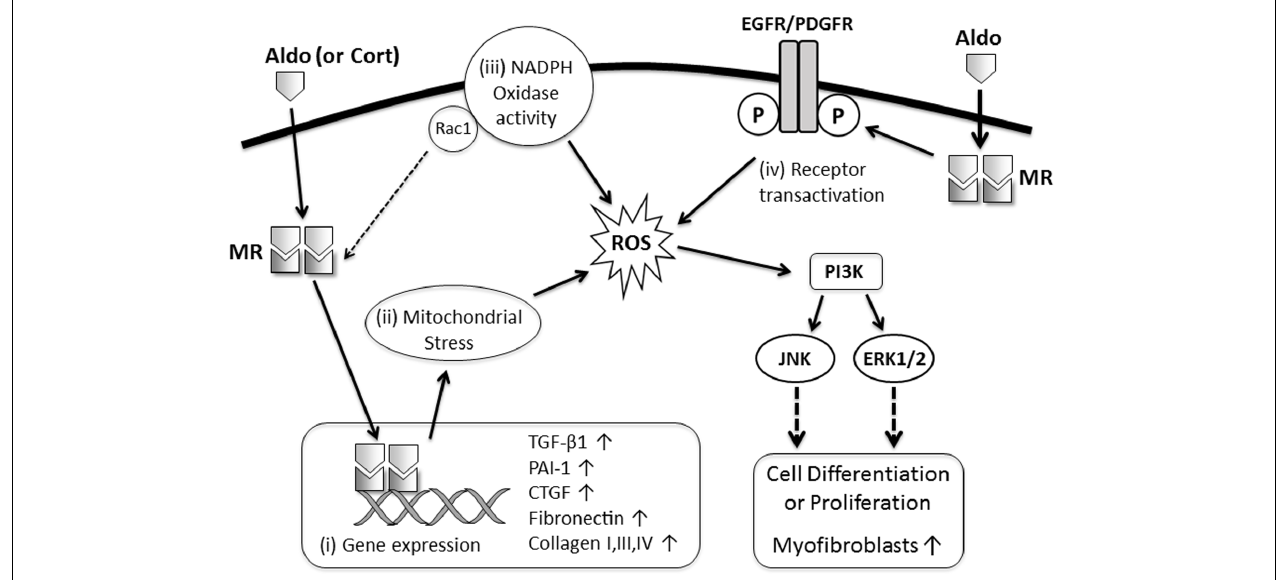
FIGURE 1 | Proposed mechanisms of MR-mediated fibrosis in the kidney and heart. MR ligands (Aldo, aldosterone; Cort, cortisol) bind with cytoplasmic MR resulting in: (i) translocation of the MR to the nucleus and activation of transcription of profibrotic genes (TGF- β 1, PAI-1, CTGF, collagens, fibronectin); (ii) induction of oxidative stress in mitochondria resulting in transdifferentiation of epithelial and mesangial cells into a more profibrotic myofibroblast phenotype; (iii) increased nicotinamide adenine dinucleotide phosphate (NADPH) oxidase activity and oxidative stress in macrophages, cardiomyocytes, and podocytes leading to enhanced MR activation (via Rac1) and worsening inflammation and injury which subsequently promote fibrosis; or (iv) transactivation of growth factor receptors, which facilitate oxidative stress, rapid activation of mitogen-activated protein kinase (MAPK) signaling and proliferation of fibroblast-like